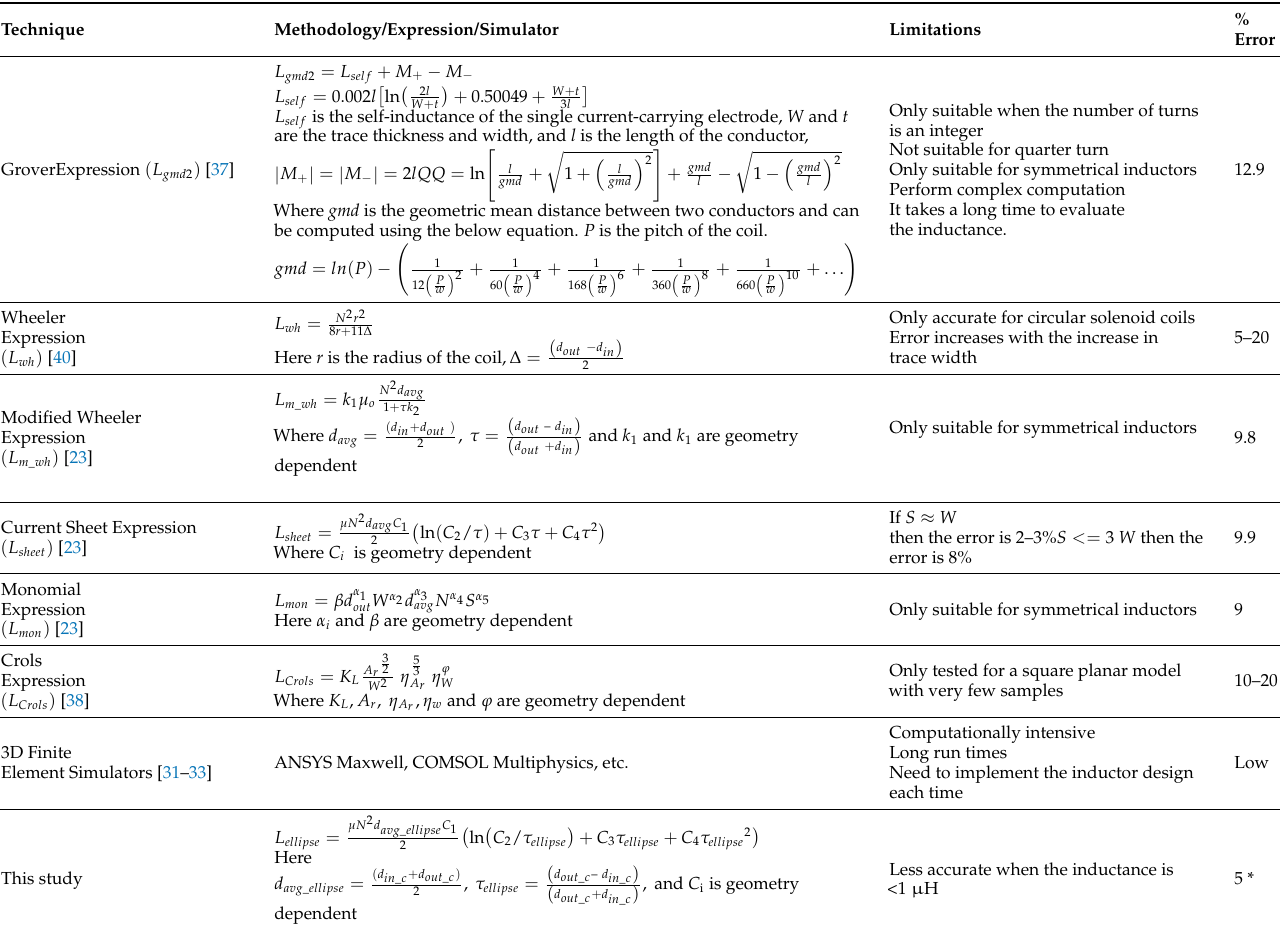
Table 15. Comparison of state-of-the-art approaches for computing the inductance of planar